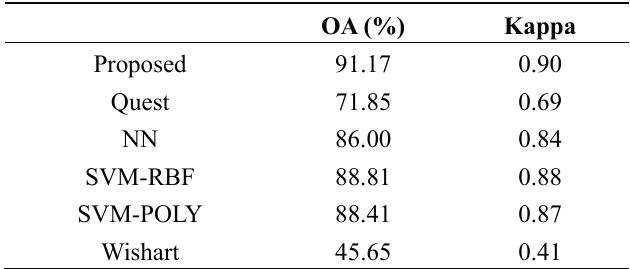
Table 8. Classification Accuracy of Different Classifiers.